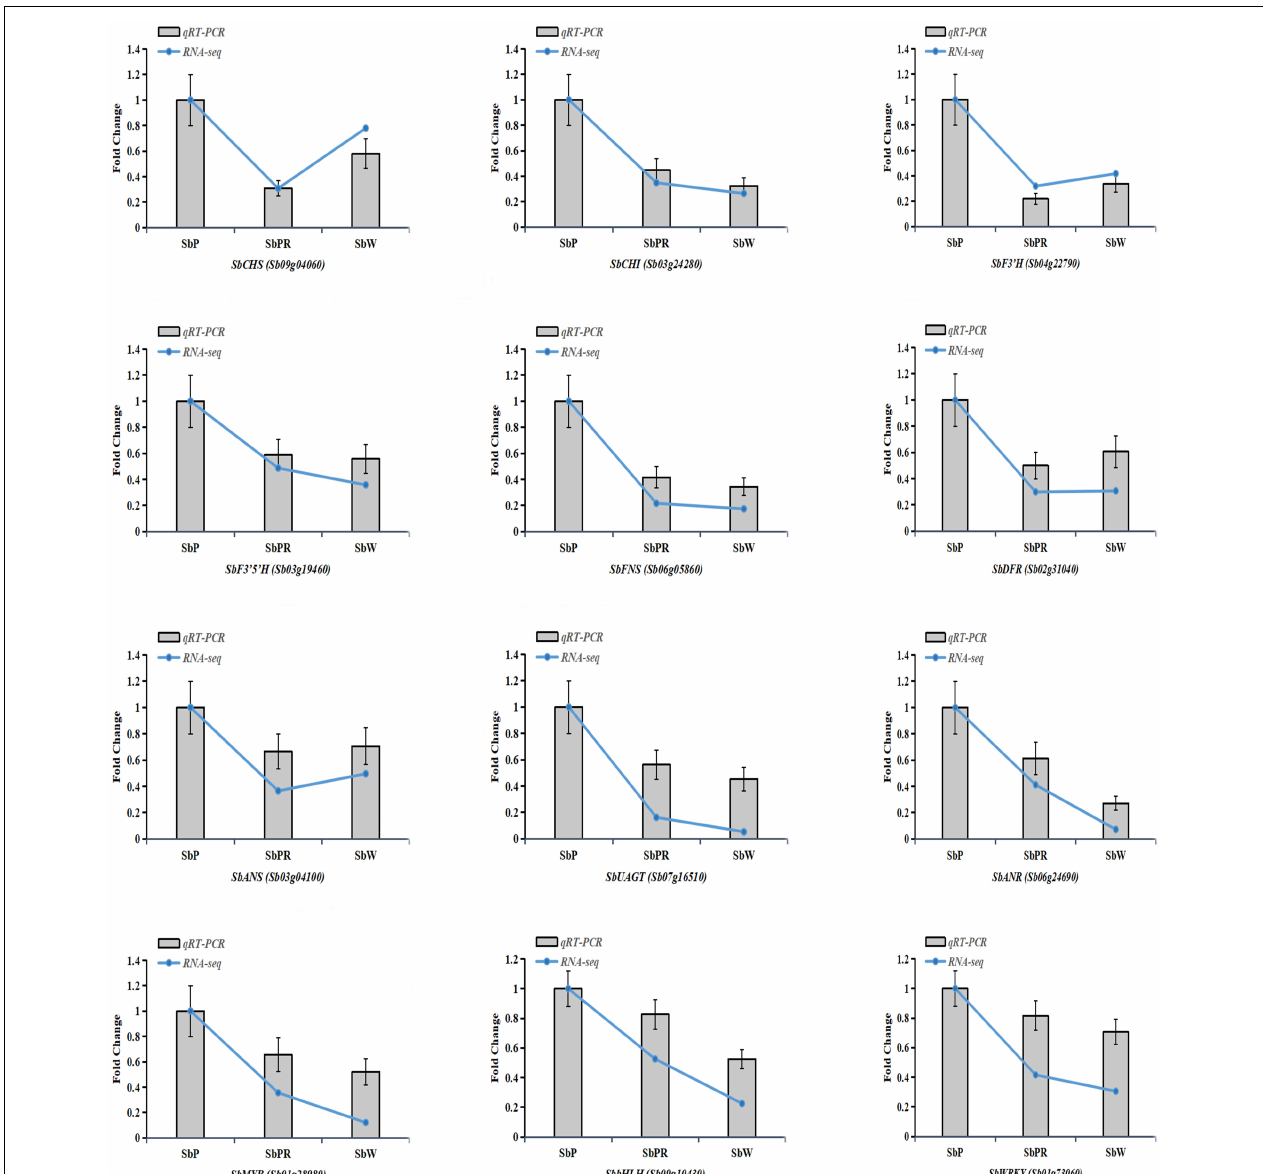
FIGURE 10 | Verification of representative genes related to anthocyanin biosynthesis by qRT-PCR. Relative expression levels of candidate genes were calculated using the actin gene as a standard. Error bars represent the standard deviation of three replicates. Curve graphs represent gene expression from the RNAseq data based on FPKM. Bar charts represent the gene expression levels calculated from qRT-PCR data based on (cid:49) Ct